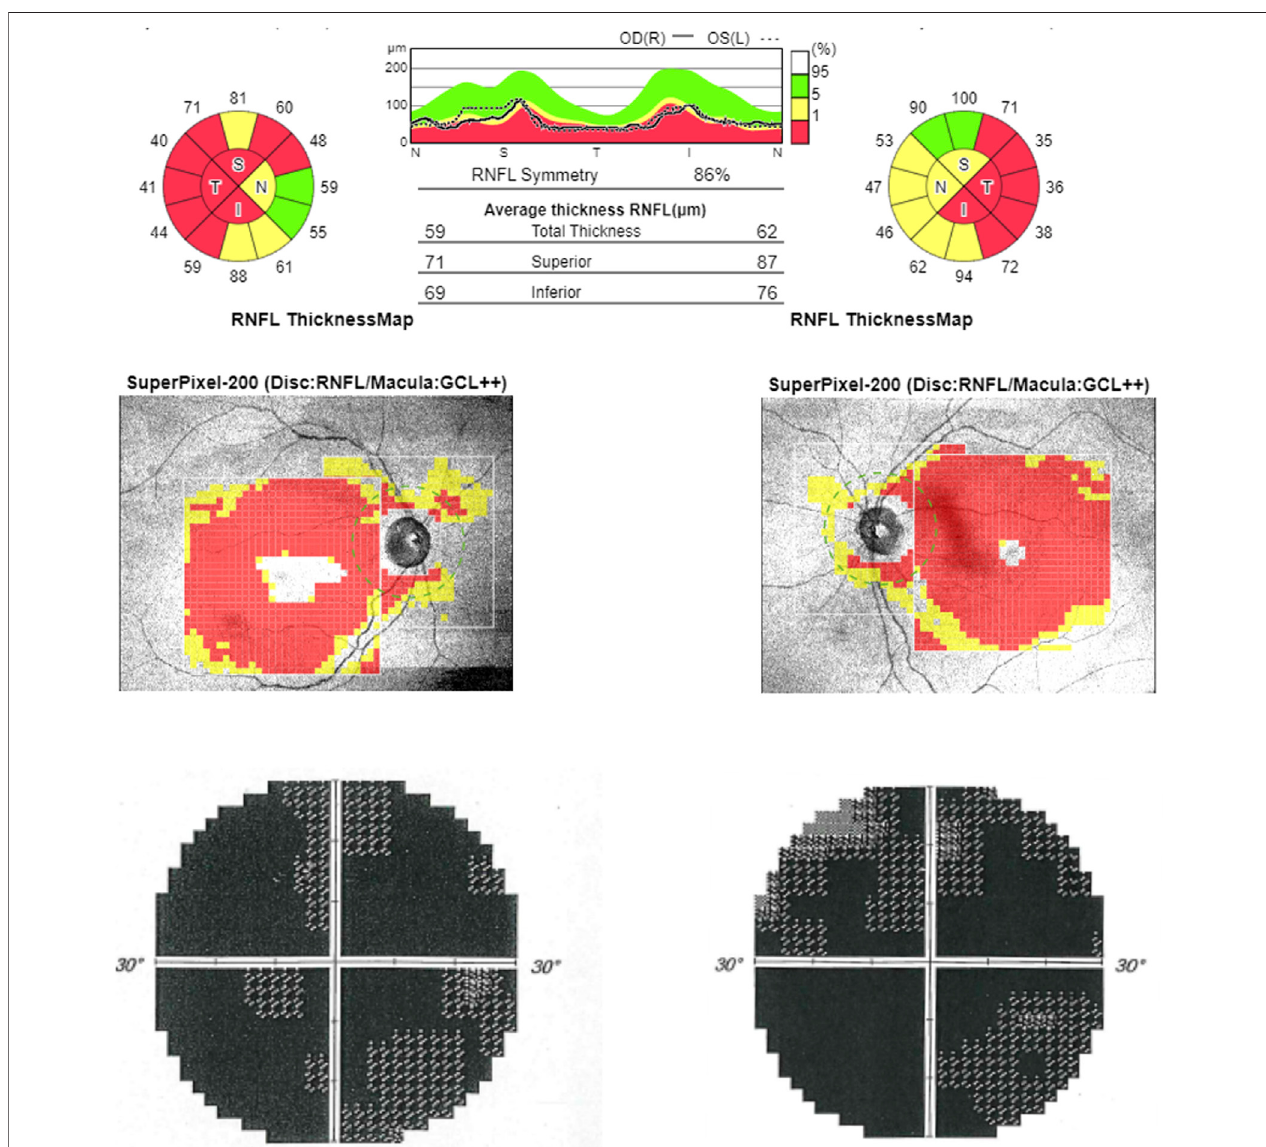
FIGURE 3 | Optical coherence tomography (OCT). OCT (upper line) shows bilateral RNFL thinning more evident in the temporal sector. Computerized visual fi elds (lower line) show a generalized defect bilaterally.